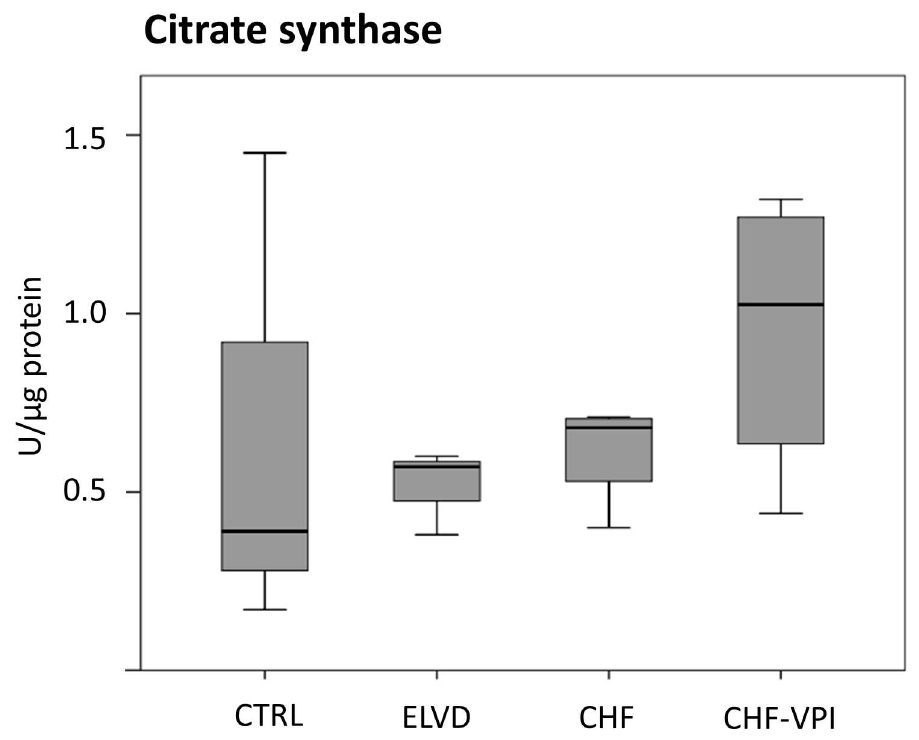
Fig 5. Citrate synthase